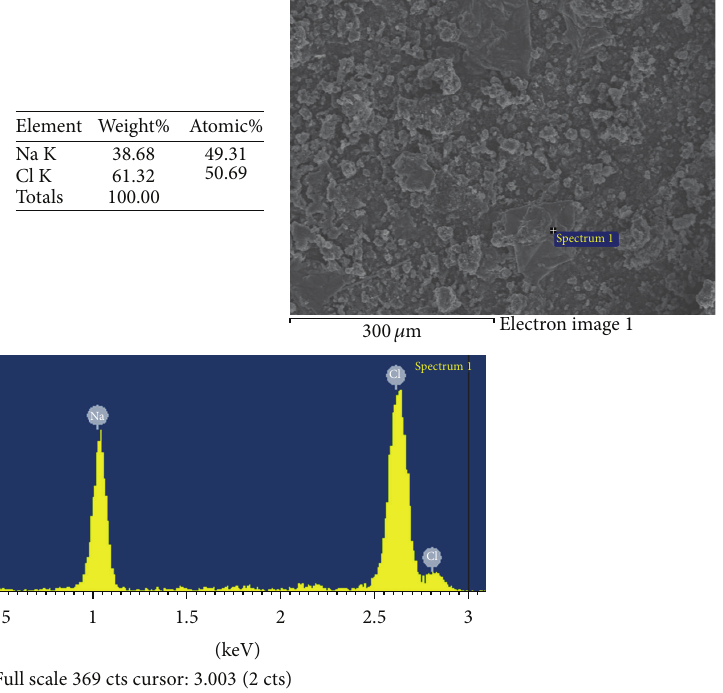
Figure 4: Analysis of the chemical composition of the sample immersed in the solution of 1-conductivity 30 𝜇 s ⋅ m.